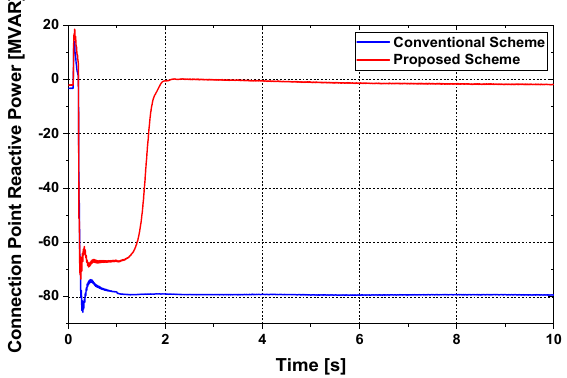
Figure 13. Reactive power response at the connection point.